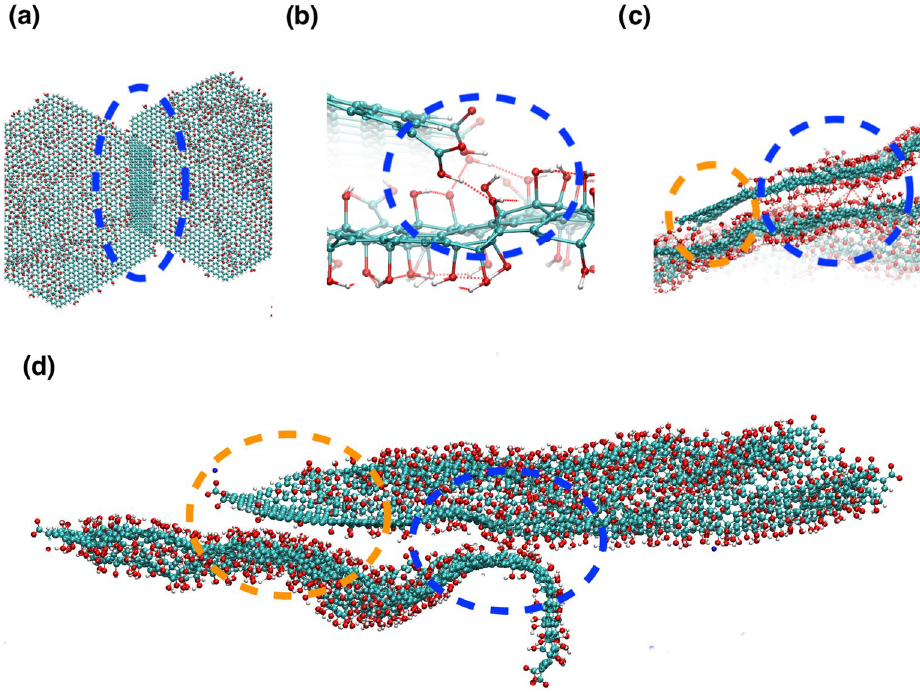
Figure 5. Snapshots from the atomistic simulations at 300K after the simulated annealing run, illustrating the different partial face-face binding modes observed for GO with a C:O ratio of 2.5. ( a )–( c ) are snapshots for uncharged ( i.e. low pH GO), ( d ) is a snapshot for charged GO flakes with Na + ions. The different binding modes are highlighted by dashed ovals and circles. ( a ) The flakes have overlapped due to 𝜋 – 𝜋 stacking interactions between sp 2 carbon atoms. ( b ) The protonated carboxylic acid atoms form hydrogen bonds with hydroxyl groups on overlapping flakes. Hydrogen bonds are shown by red dashed lines, defined by the distance between oxygen and hydrogen atoms < 4.5 Å and acceptor oxygen–donator oxygen–hydrogen atom angle < 40 Blue circle: hydroxyl groups form hydrogen bonds with hydroxyl groups on overlapping flakes. Orange circle: sp 2 carbon atoms are interacting with an area of oxidised graphene oxide on an adjacent sheet, via van der Waal’s interactions. ( d ) Binding modes for two charged GO sheets with Na + ions. The orange circle highlights interactions between a sp 2 carbon atoms and hydroylated regions on an adjacent flake, the blue circle shows hydrogen bonded interactions between the flakes. The lower flake has become wavy and contorted to keep apart the charged carboxylate